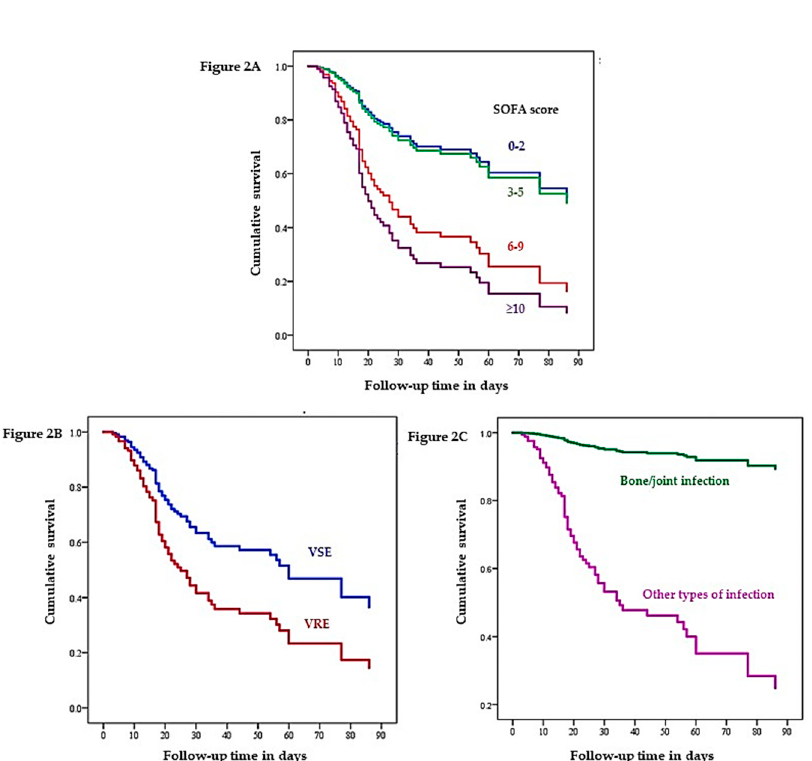
Figure 2. Cox proportional hazards cumulative 90-day survival curves with respect to different SOFA score groups ( A ), vancomycin susceptibility pattern ( B ), and bone/joint infection vs. other type of infections ( C ) after sepsis adjusted for other significant variables (age ≥ 70 years, vancomycin resistance, bone/joint infection, or bloodstream infection). Abbreviations: SOFA, sequential organ failure assessment; VRE, vancomycin resistant Enterococci ; VSE, vancomycin susceptible Enterococci